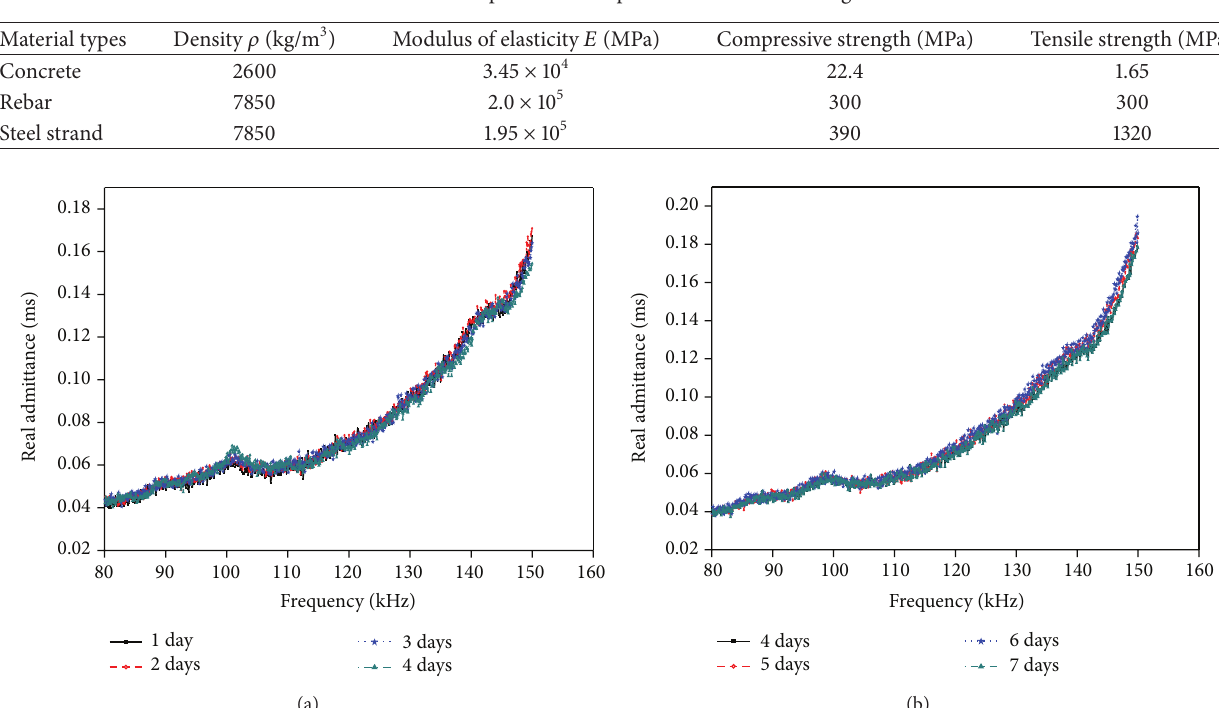
Table 2: Material parameters of prestressed concrete box girders.